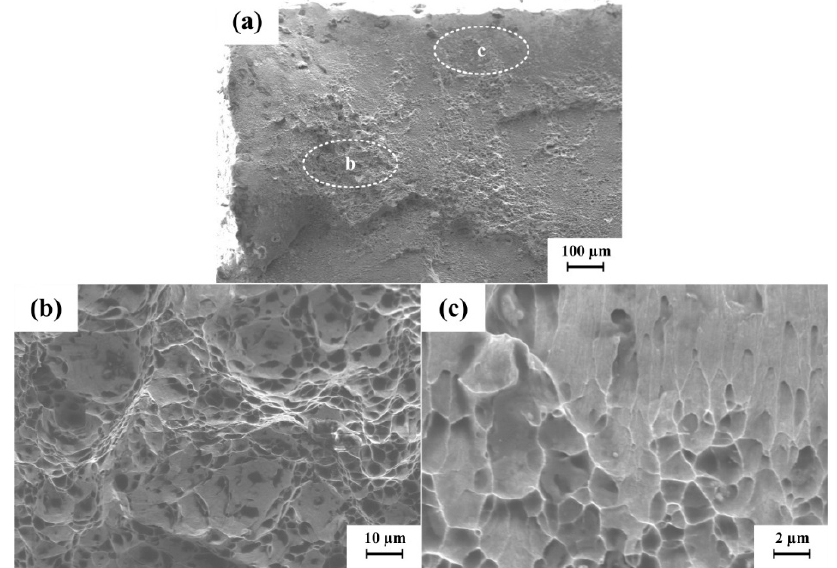
Figure 10. The fracture morphology of the 304 stainless-steel UNSM specimen .